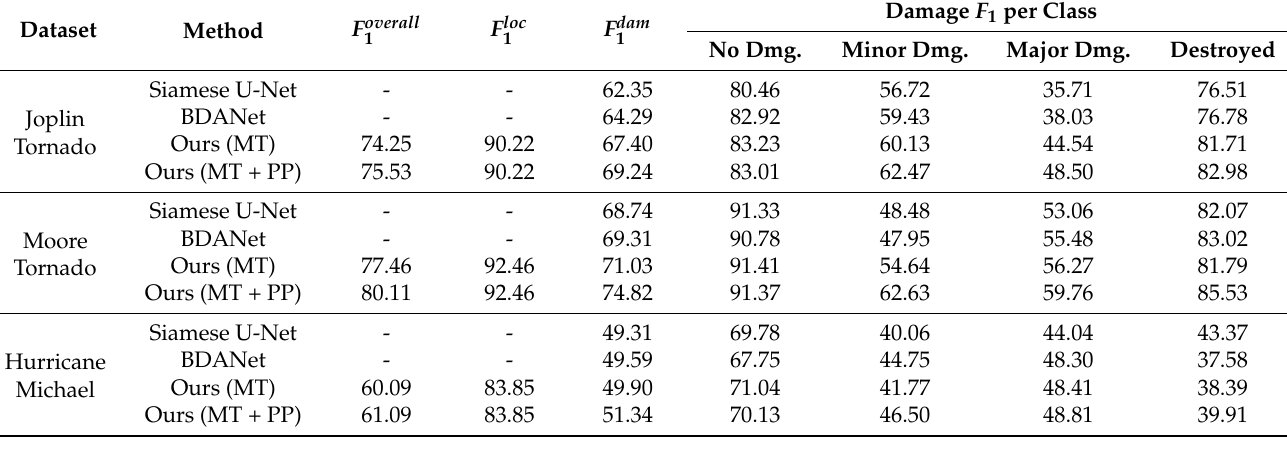
Table 2. Quantitative comparison of different SL methods on three datasets (%).